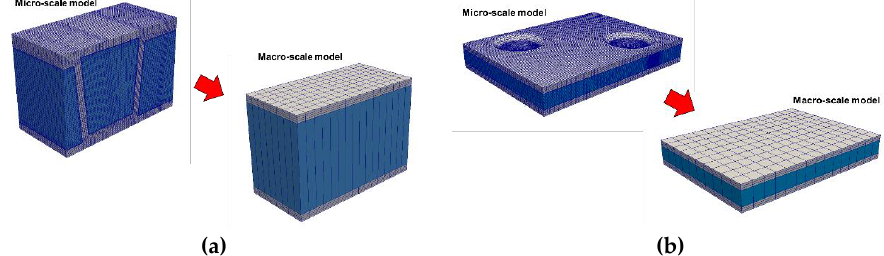
Figure 3. Definition of the macro-scale model of a turbulator in the case of offset-strip fins ( a ) and dimple-type ( b ).